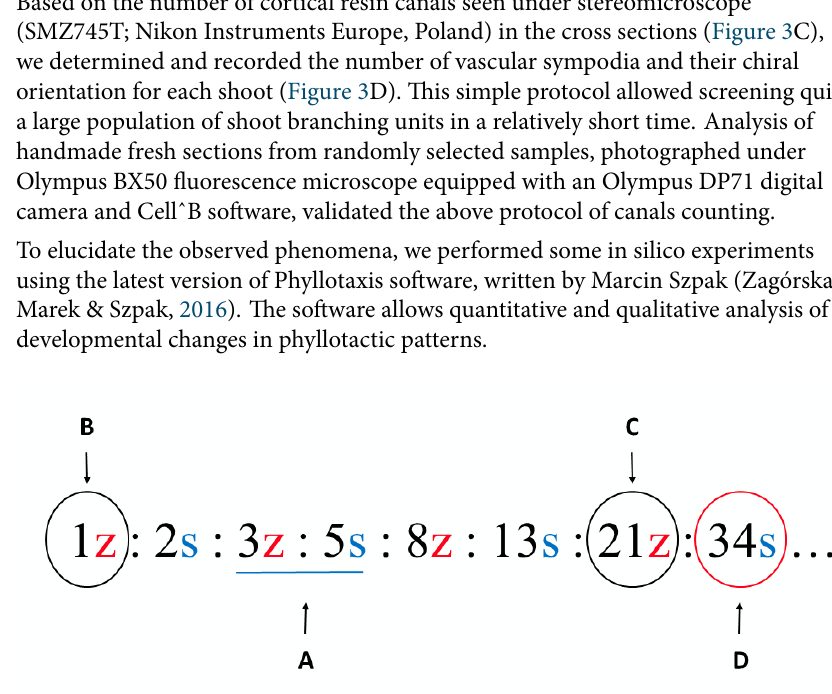
Figure 3 Protocol used to determine properties of phyllotaxis and vascular system. ( A ) Phyllotactic pattern identified through the formula of contact parastichy pair (blue underline). ( B ) Chiral orientation of ontogenetic helix deduced by extrapolating the empirically detected numbers of parastichies to the first number in phyllotactic series – in this case the main Fibonacci series. ( C ) The number of resin canals counted on the shoot cross section, based on the visible droplets of outflowing resin; information on canals chiral orientation drawn from extrapolated phyllotactic series. ( D ) The number and chiral orientation of vascular sympodia deduced from the number and orientation of resin